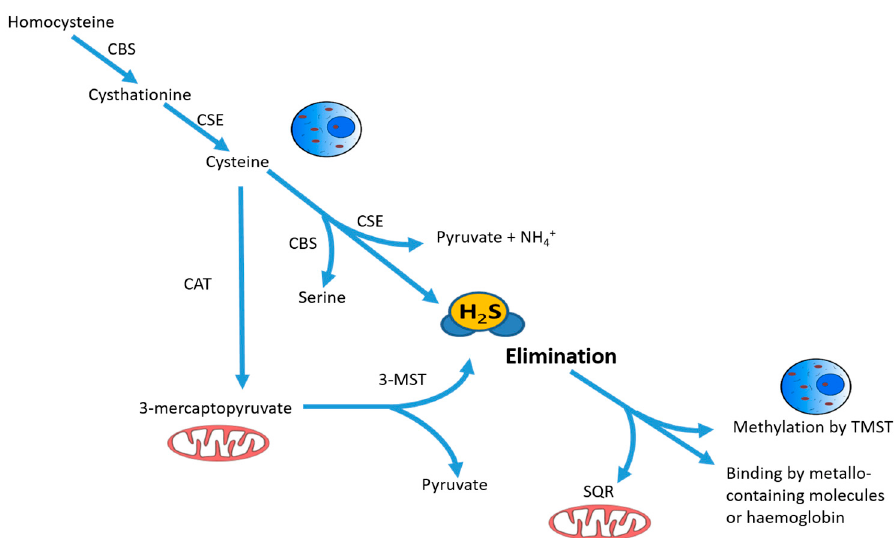
Figure 1. Schematic description of intracellular synthesis and degradation of hydrogen sulfide H 2 S.